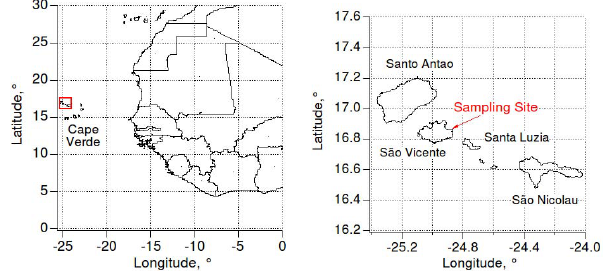
Figure 2. Location of the sampling site.